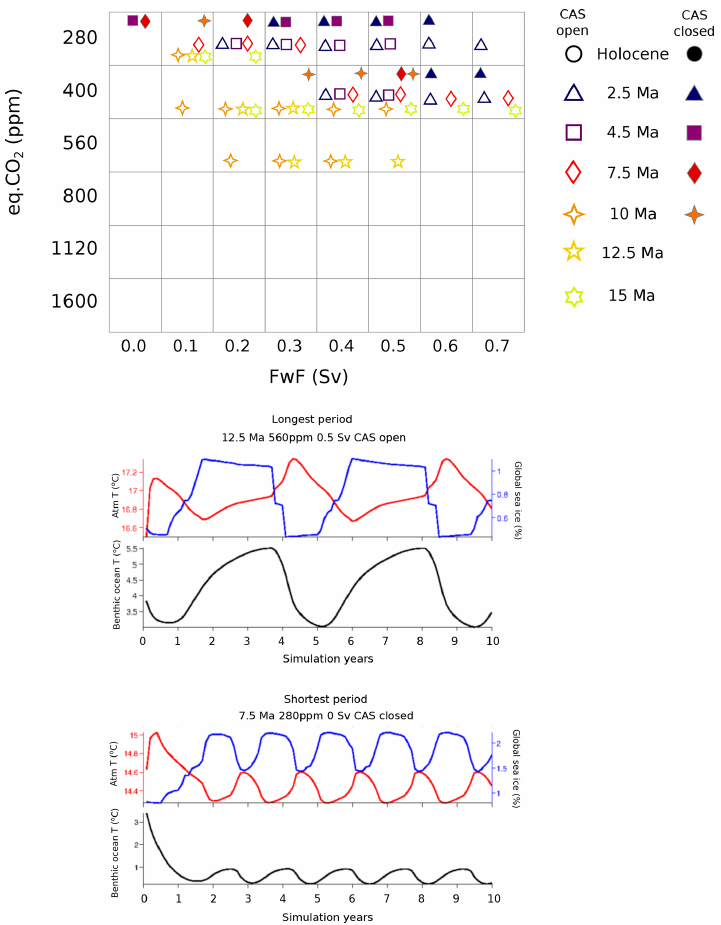
Figure C1. Ensemble settings that displayed sustained oscillations in benthic ocean temperature (top). Model output for atmospheric tem- perature, sea ice, and benthic temperature for the longest- and shortest-period oscillations (bottom panels).